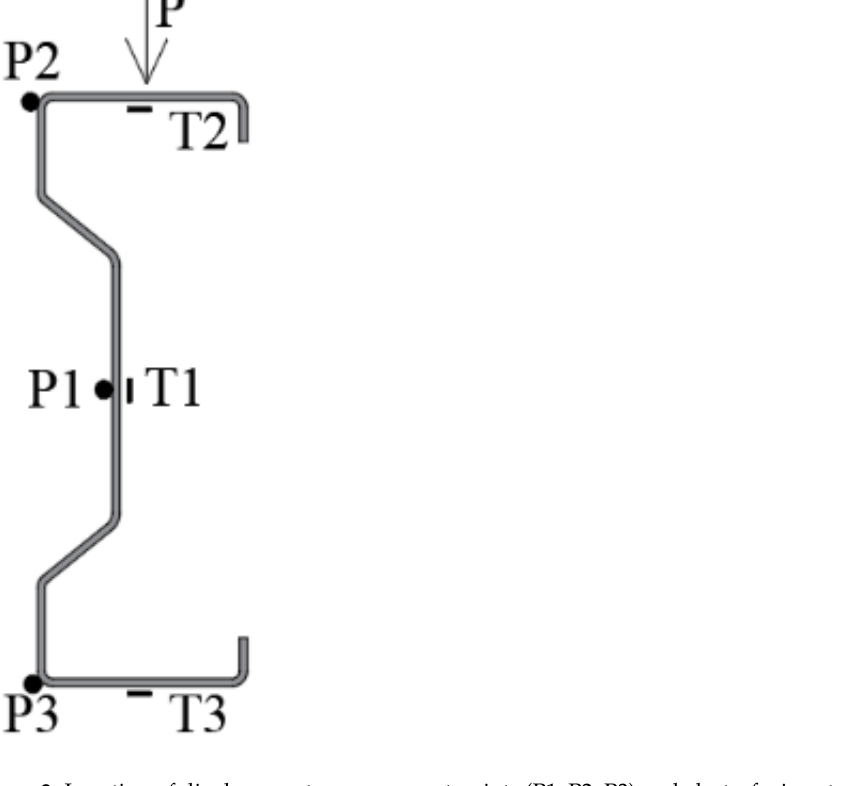
Figure 3. Location of displacement measurement points (P1, P2, P3) and electrofusion strain gauges in the middle of the beam span.